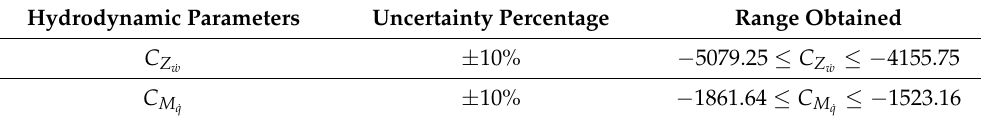
and C M in vertical plane. ˙ w ˙ q